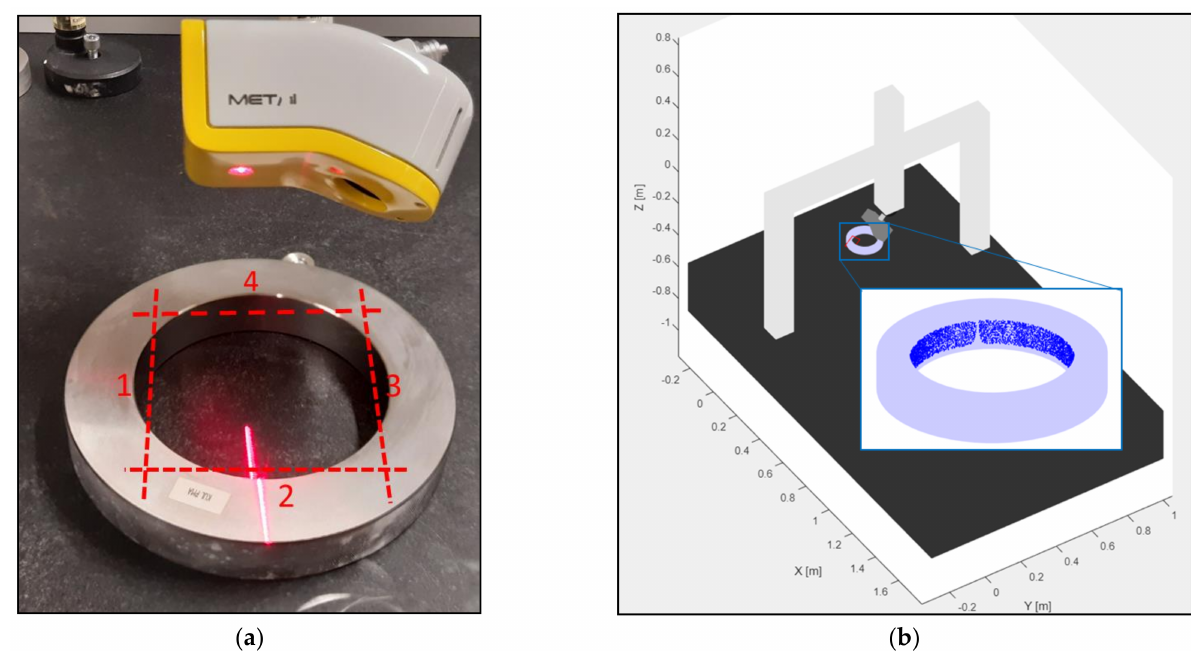
Figure 15. ( a ) The scan trajectories (red dashed lines) of the measurement of the inner cylinder; ( b ) The data (blue dots) of the simulated measurement in the digital environment.